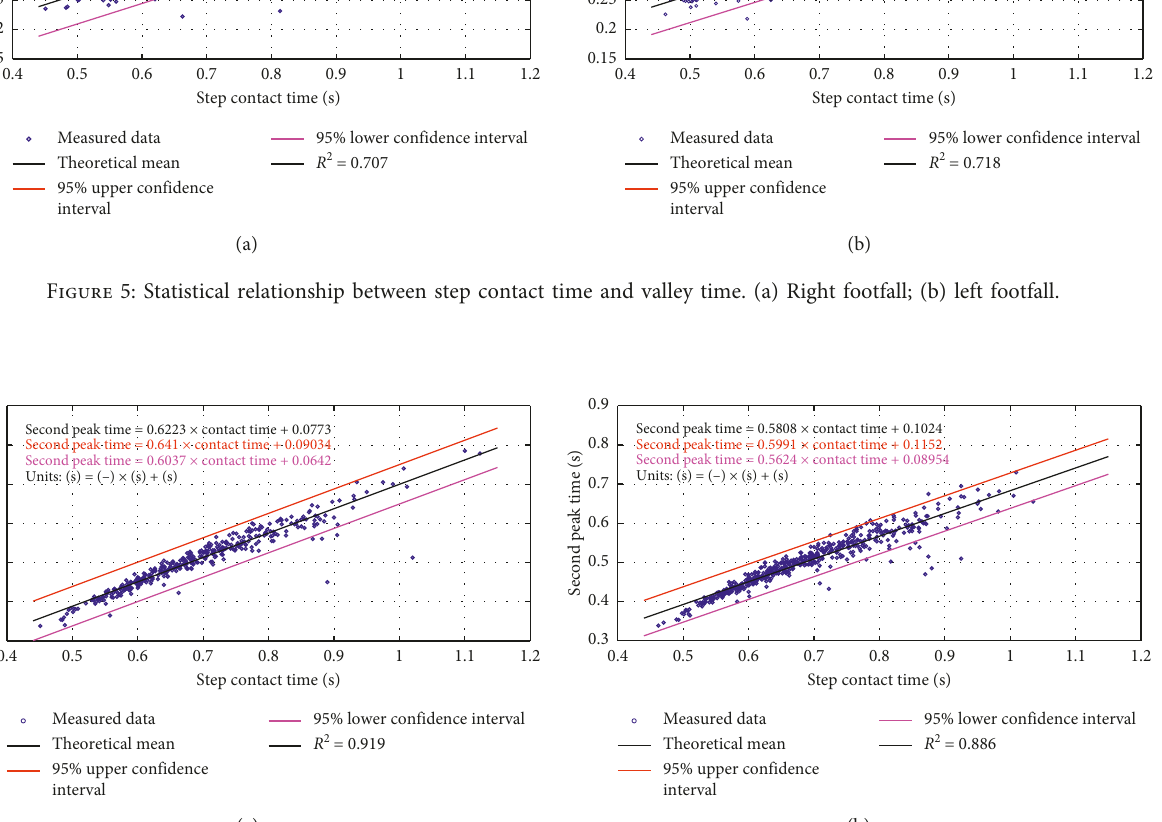
0.150.20.250.30.350.40.450.50.55